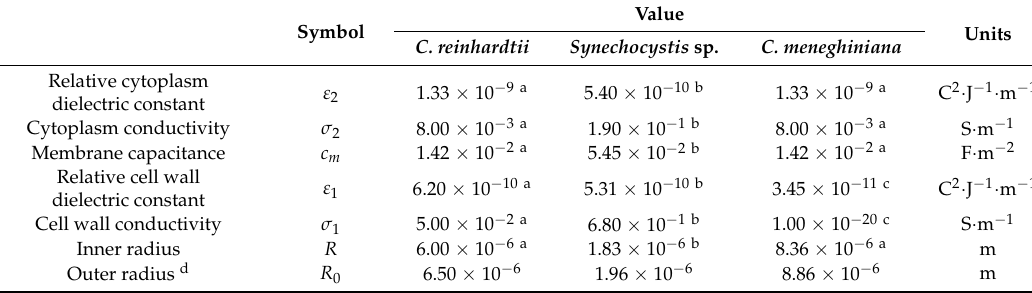
Table 1. Numerical parameters used to calculate the effective polarizability of green microalga C. reinhardtii , cyanobacterium Synechocystis sp. and diatom C.